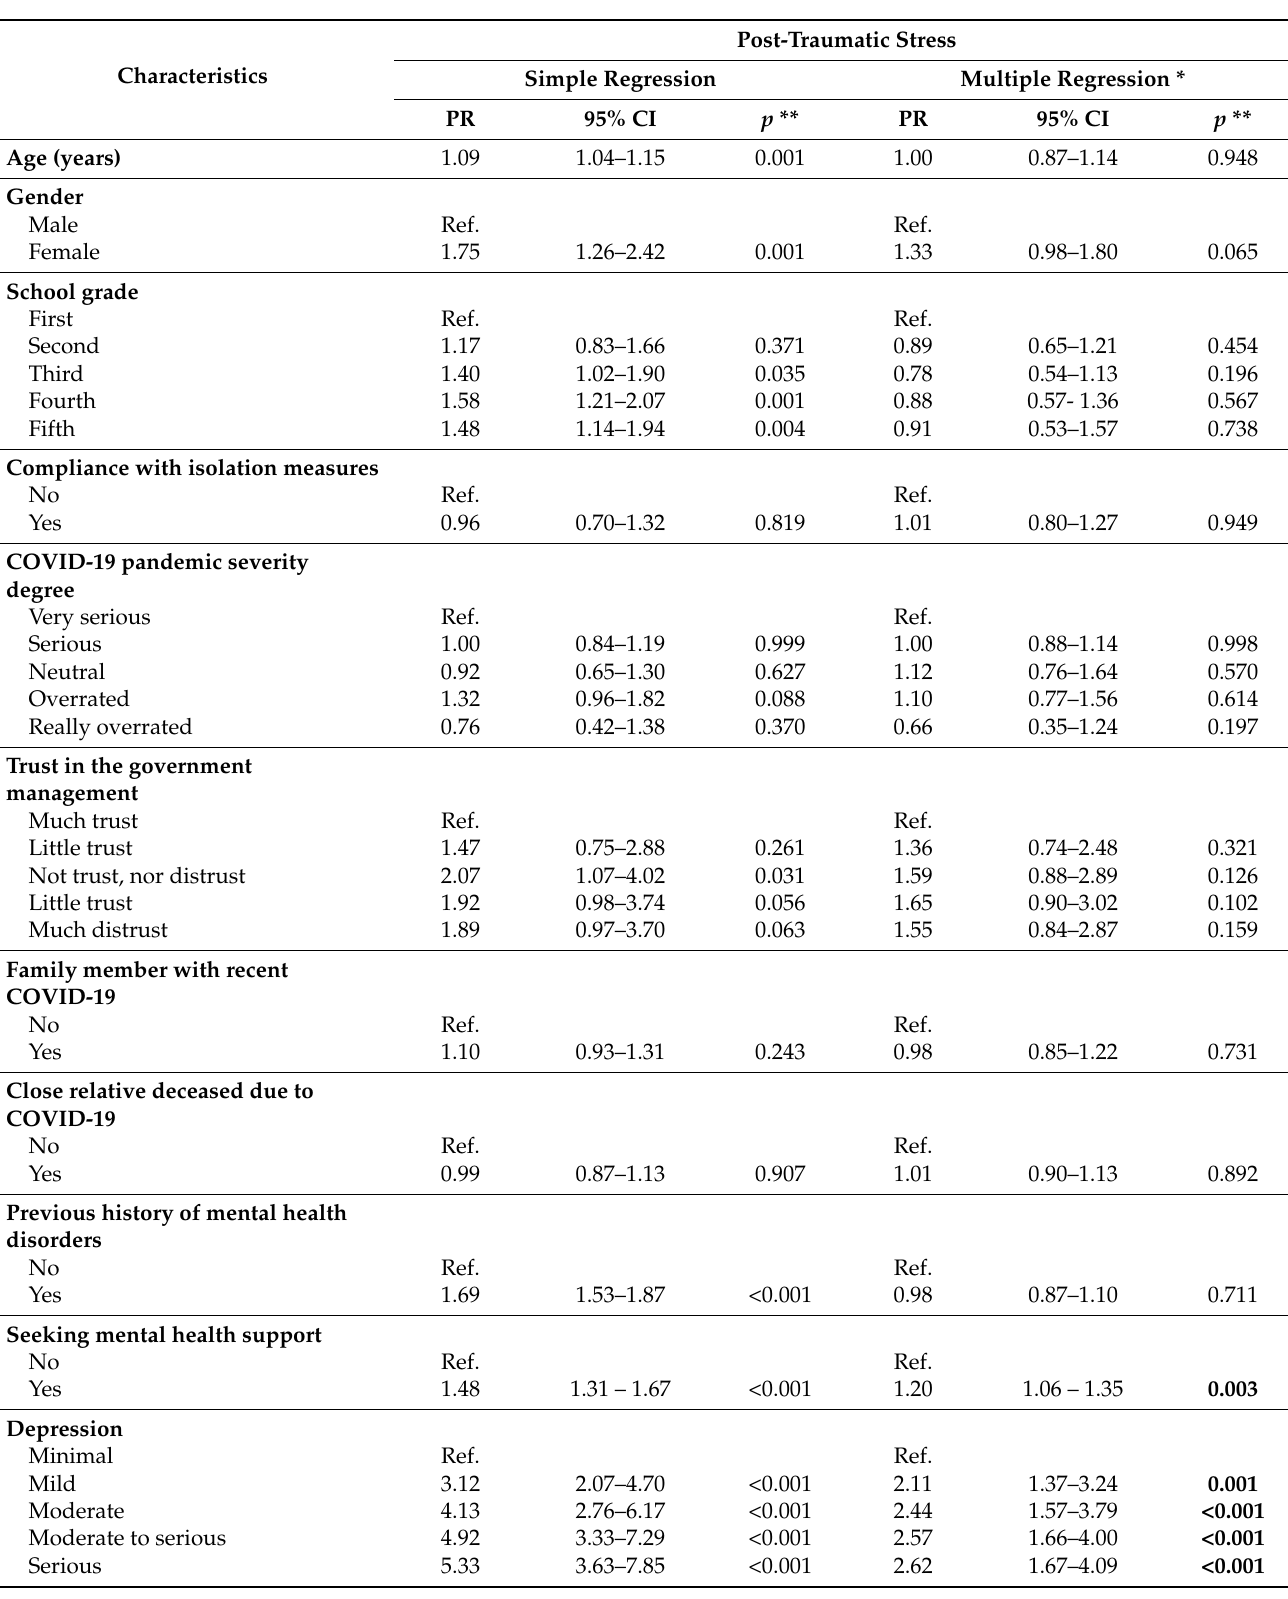
Table 3. Factors associated with post-traumatic stress disorder in students at three schools in Chiclayo, 2021, simple and multiple regression